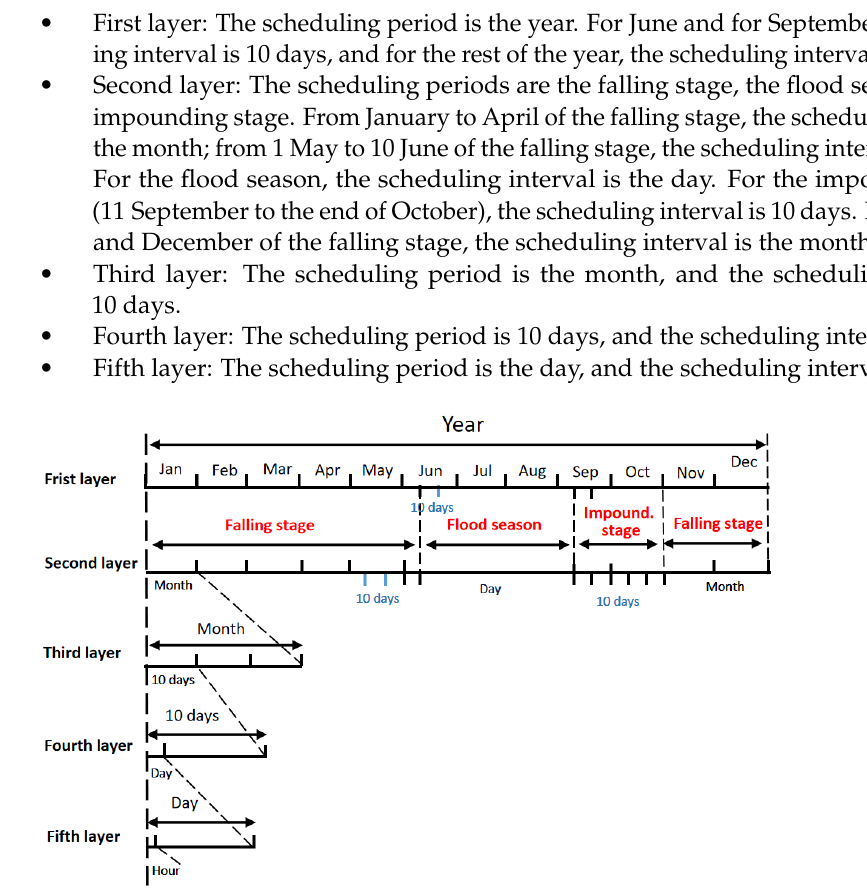
Figure 2. Division of scheduling periods for TG-GZB cascade